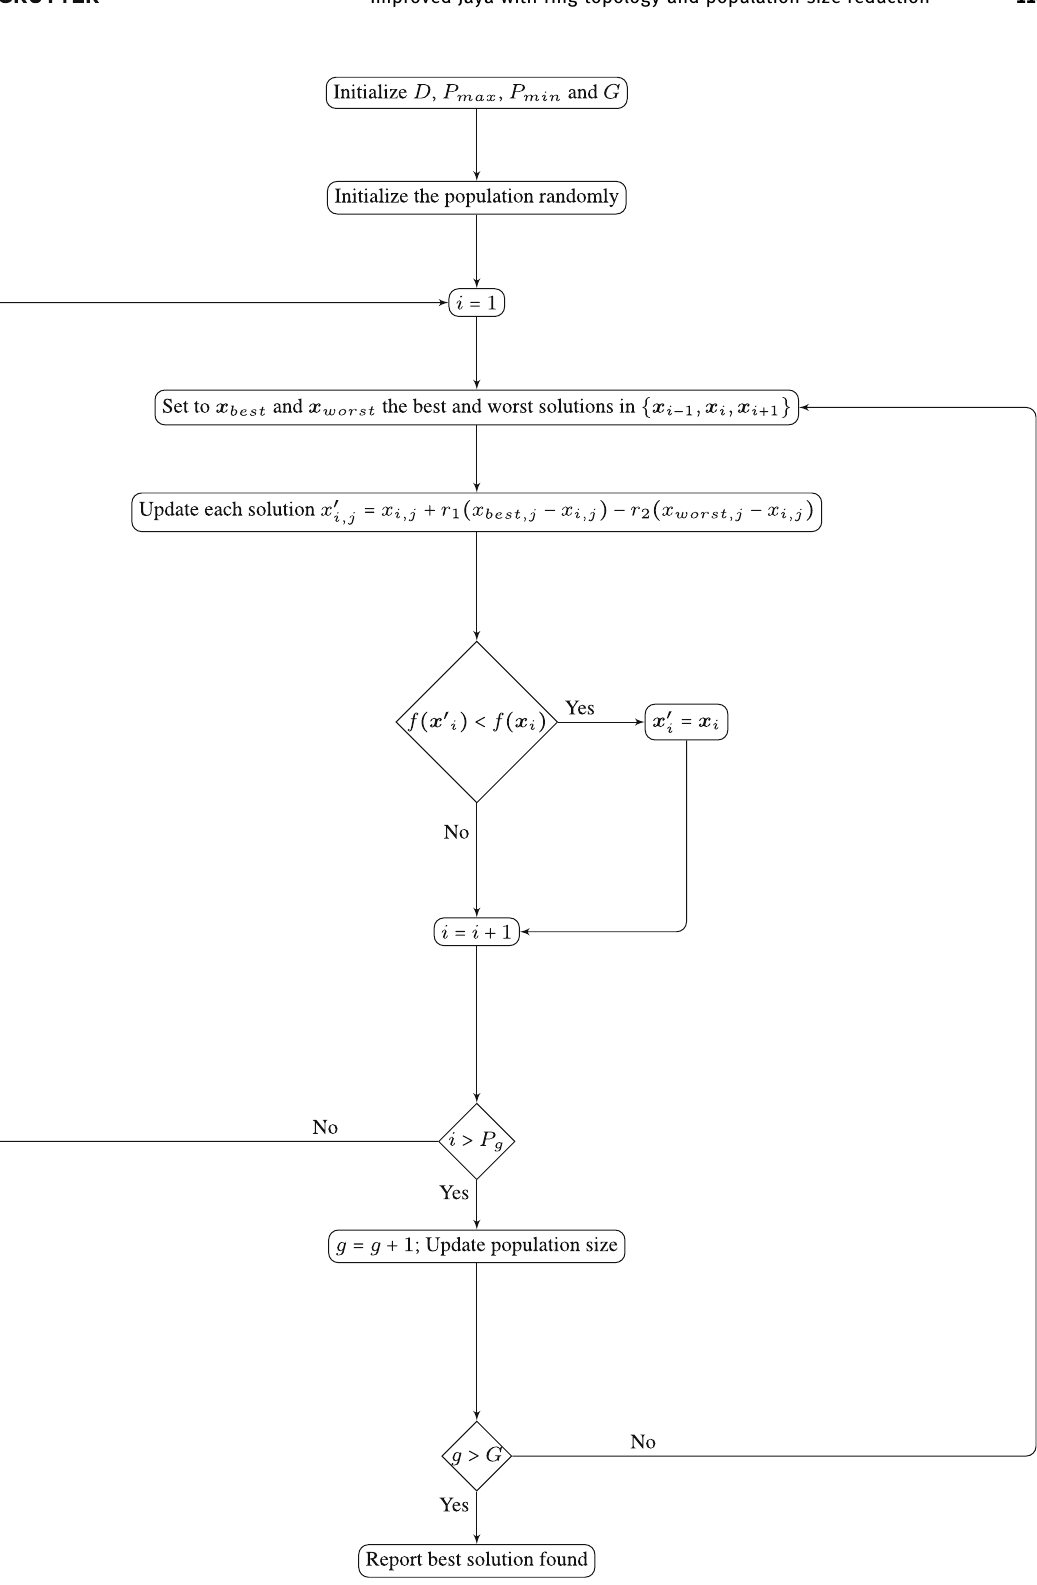
Figure 3: Flowchart of the Jaya2